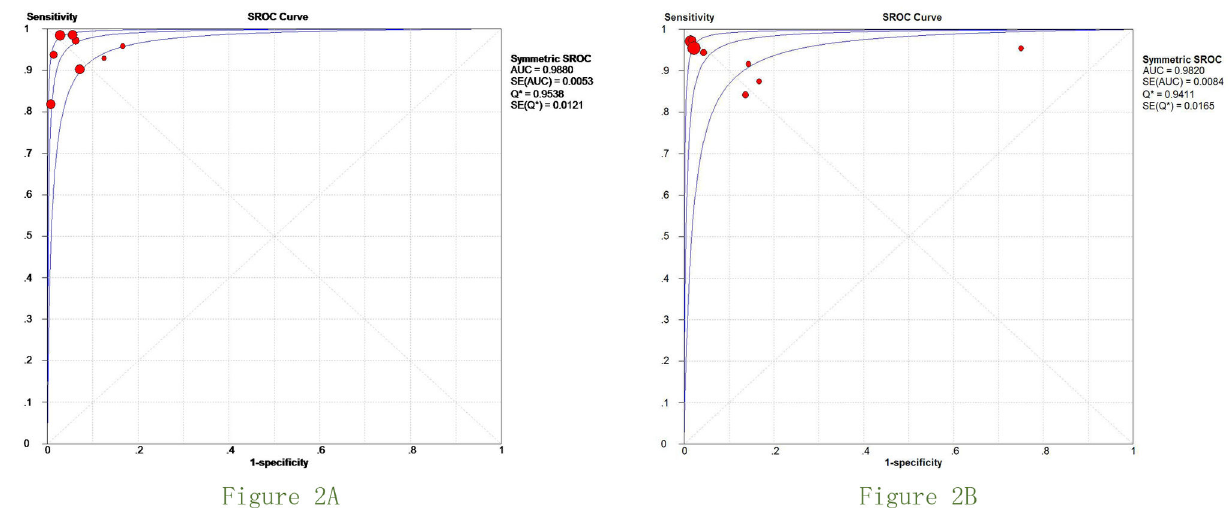
Figure 2. Summary ROC (SROC) curves for CTA and MRA.